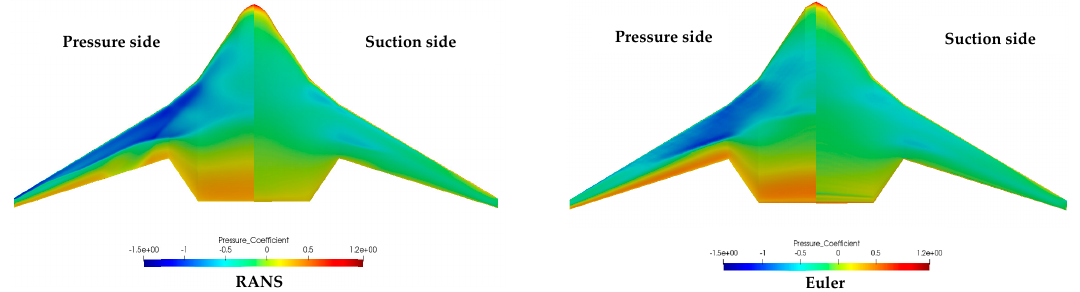
Figure A13. Pressure coefficients for RANS and Euler simulations at AoA = -2 deg.